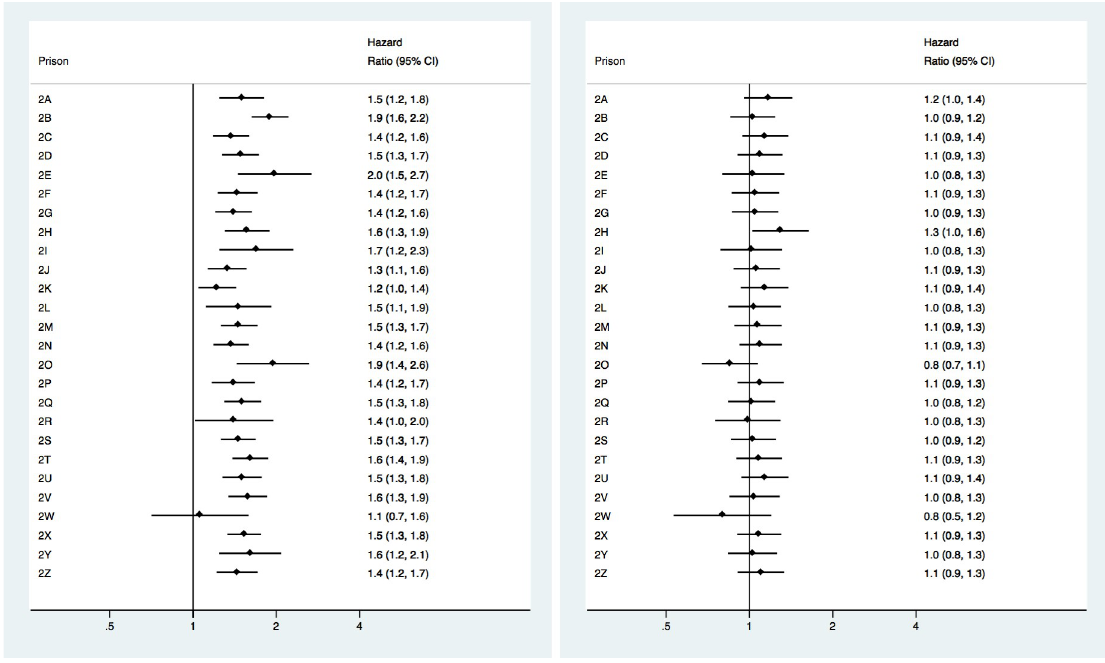
Fig 2. A. Between-individual analyses of recidivism risk among prisoners released from medium security prisons (level 2). B. Within- individual analyses of recidivism risk among prisoners released from medium security prisons (level 2).